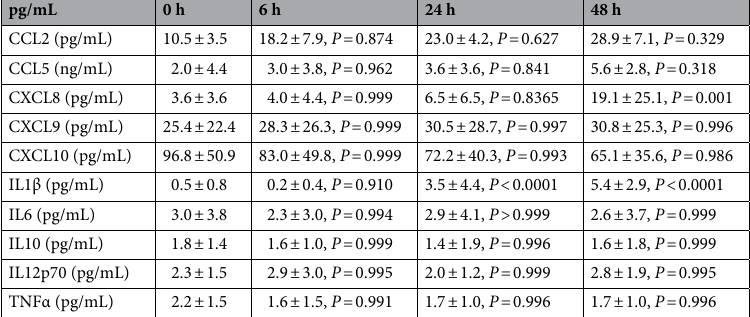
Table 2. Plasma cytokines and chemokines. Data from 5 healthy donors: one male age 37, 4 females age 25, 30, 34, 41. Values are shown as the mean ± 95% confidence interval. Statistical significance is vs 0 h measurement, determined by Dunnett’s pairwise comparison.